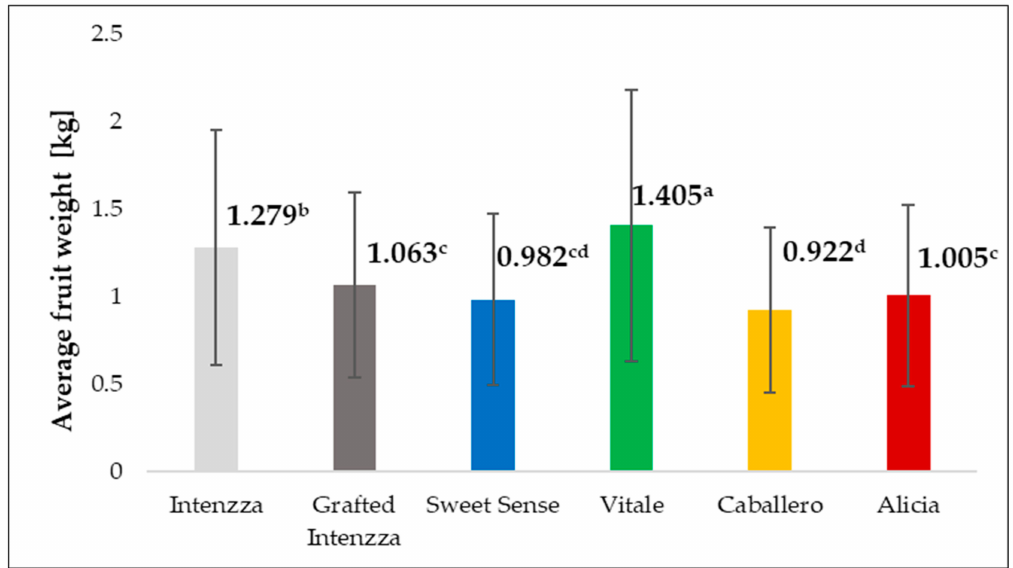
Figure 4. Average fruit weight of the five cultivars of papaya in (kg). T0 ( (cid:4) ): Intenzza; T1 ( (cid:4) ): Grafted Intenzza; T2 ( (cid:4) ): Sweet sense; T3 ( (cid:4) ): Vitale; T4 ( (cid:4) ): Caballero; T5 ( (cid:4) ): Alicia, planted under greenhouse. Di ff erent letters mean significant di ff erences, at p -value <